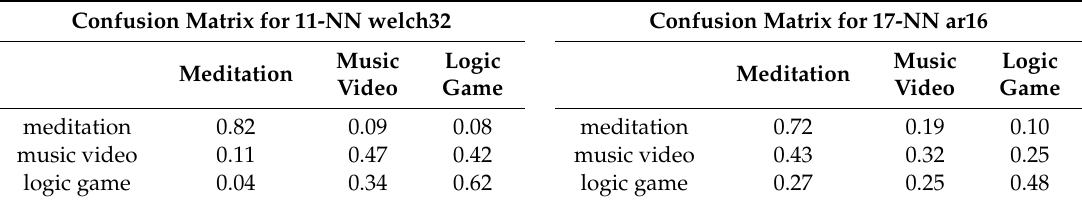
Table 4. Normalized confusion matrix for the 11-NN classifier and the welch32 feature extraction scheme (left). Normalized confusion matrix for the 17-NN classifier and the ar16 feature extraction scheme (right).